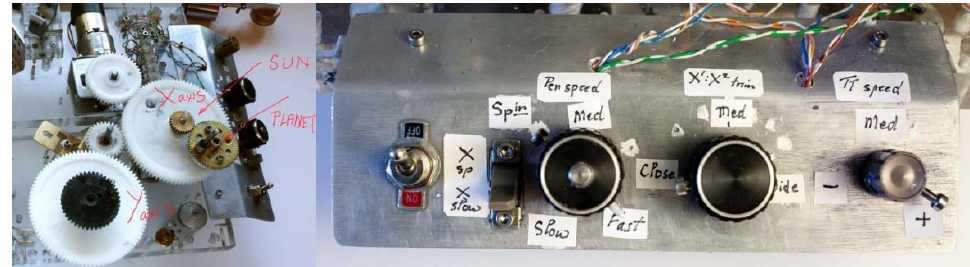
Figure 6. X axis sun and planet drive with the Y axis fixed plus controls; potentiometers used as resistors.